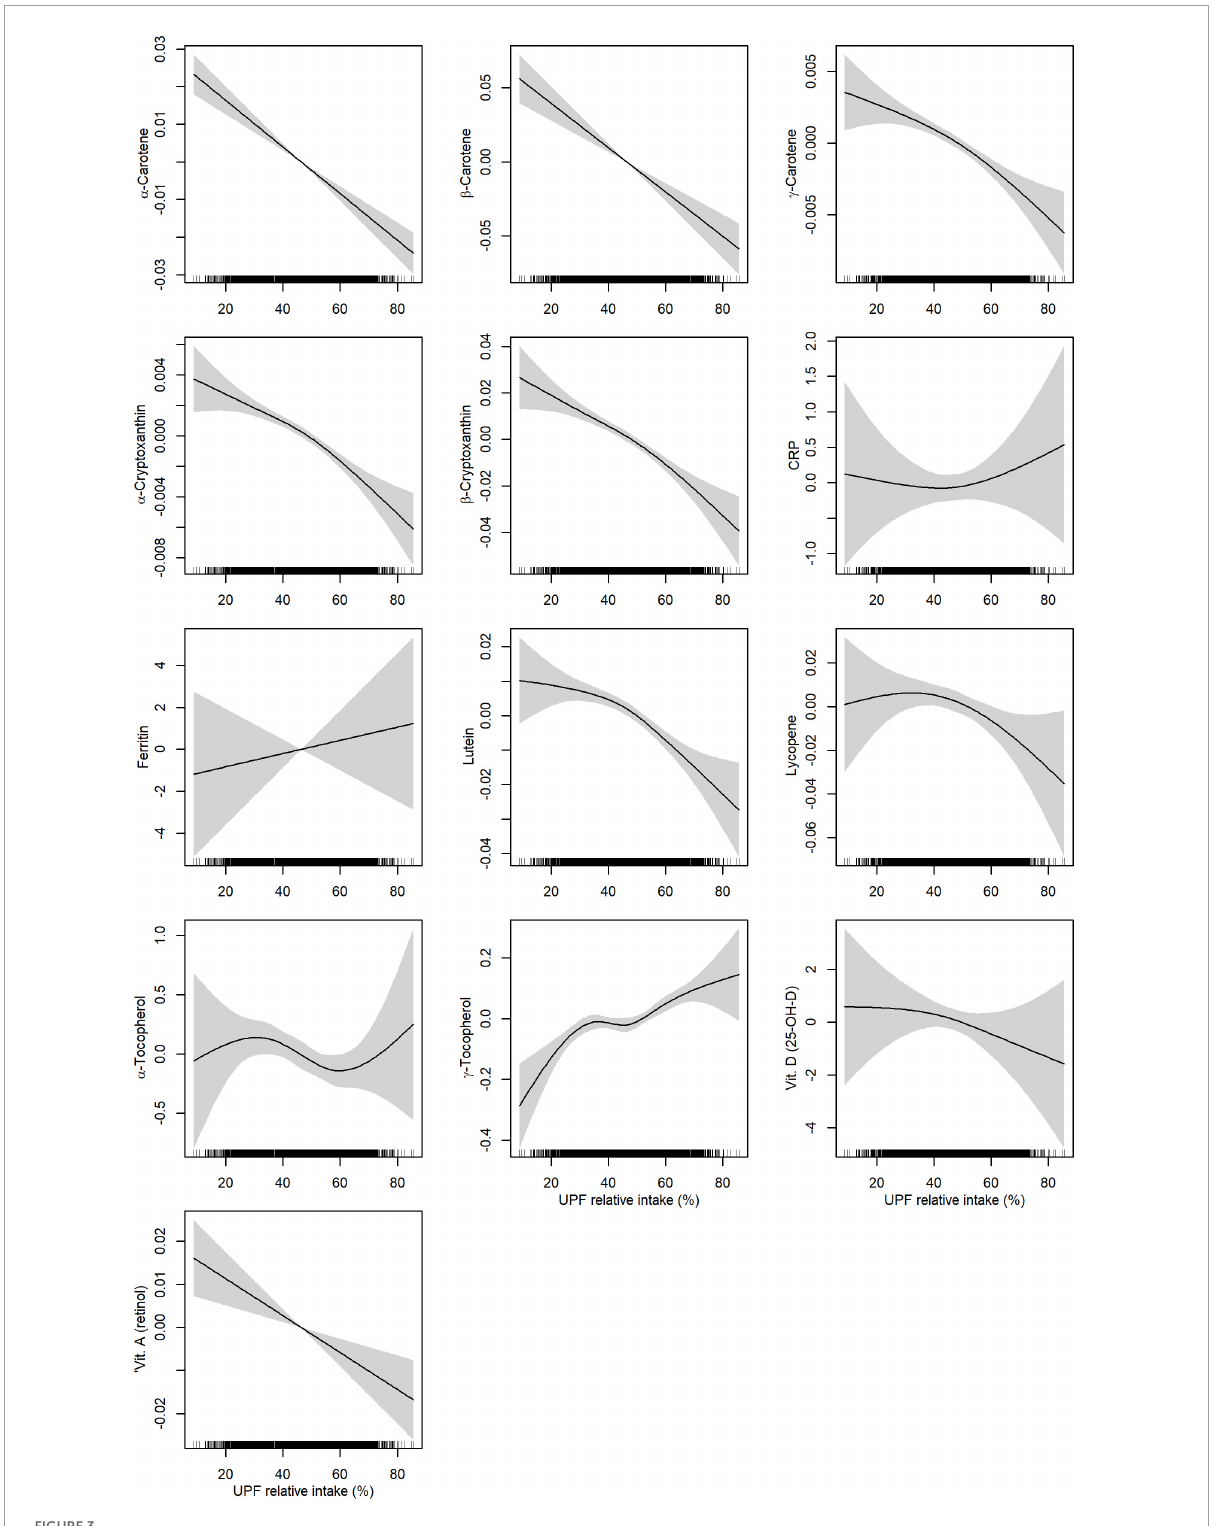
FIGURE3 Adjusted associations between relative intake of ultra-processed food (UPF) and biomarkers measured in plasma. Associations were estimated by non-parametric generalized additive models using a restricted cubic spline with five knots as smoother. Adjusted for age at delivery, parity, pre-pregnancy BMI, education level, alcohol intake, and smoking status. CRP, C-reactive